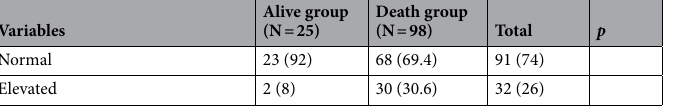
Table 1. Baseline demographics and clinical characteristics of HOS patients in the alive group and death group. The cut-off value was determined based on receiver operating characteristic curve analysis (ROC).